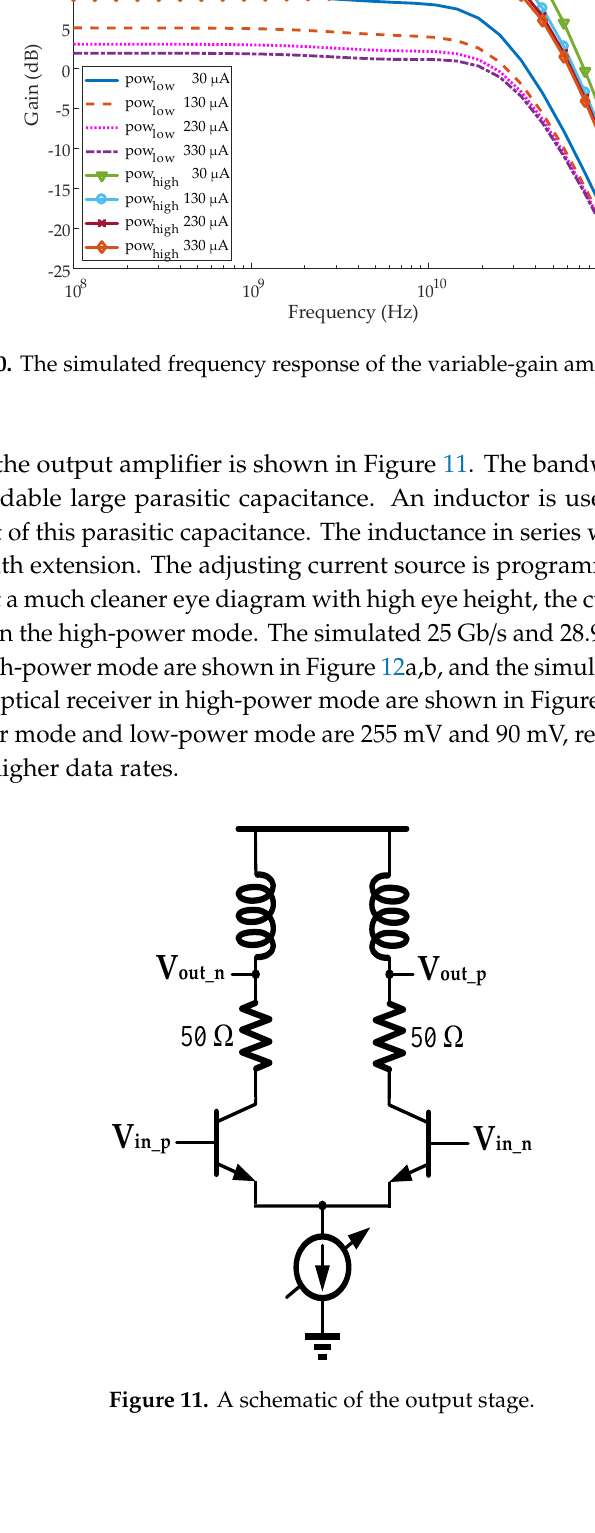
Figure 10. The simulated gain of the VGA varies from 16.5 dB to 9.1 dB in high-power mode, and the gain of the VGA varies from 9.1 dB to 1.8 dB with the current reduced in low-power mode.